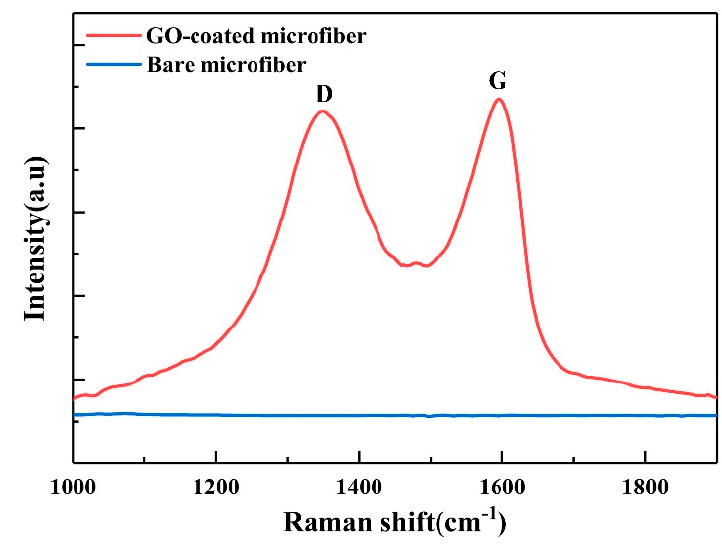
Figure 6. Raman spectra of bare and GO-coated microfiber.